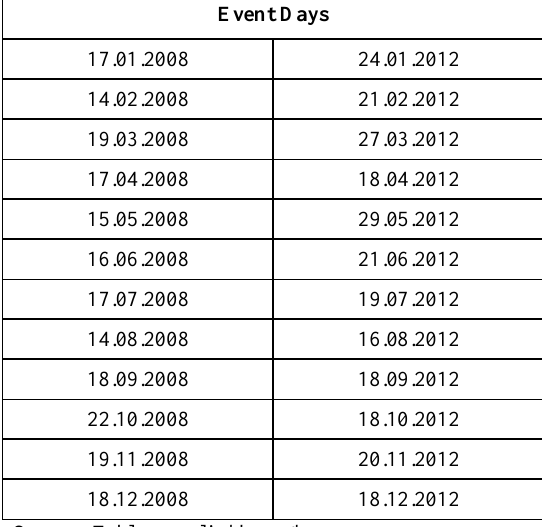
Table 1: Event Days (Announcement Days of Monetary Policy Decisions) Event Days